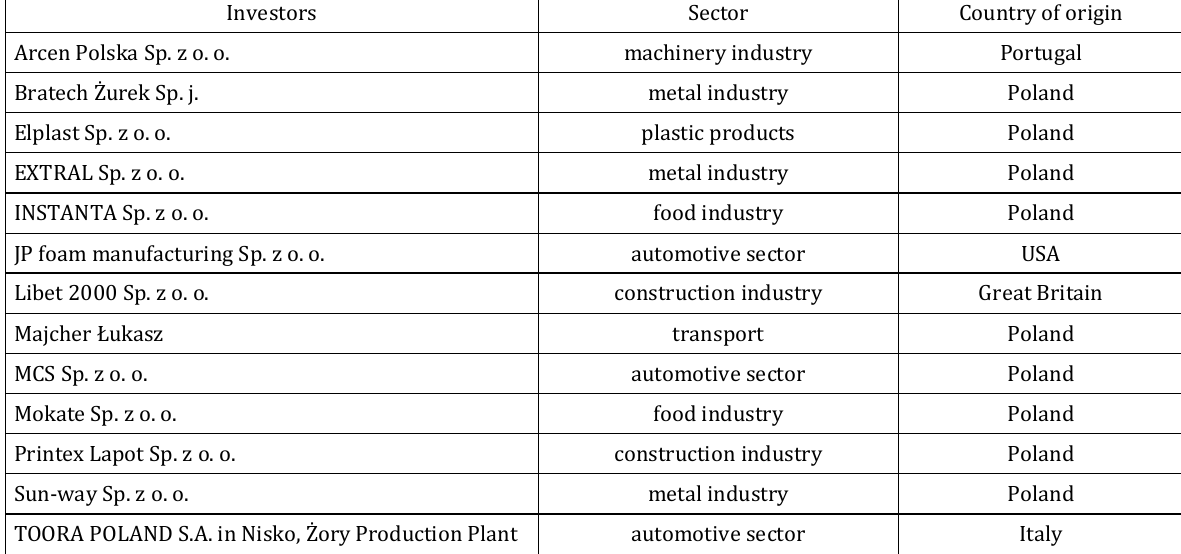
Table 1. Investors acting in the Katowice Special Economic Zone (KSEZ) Investors